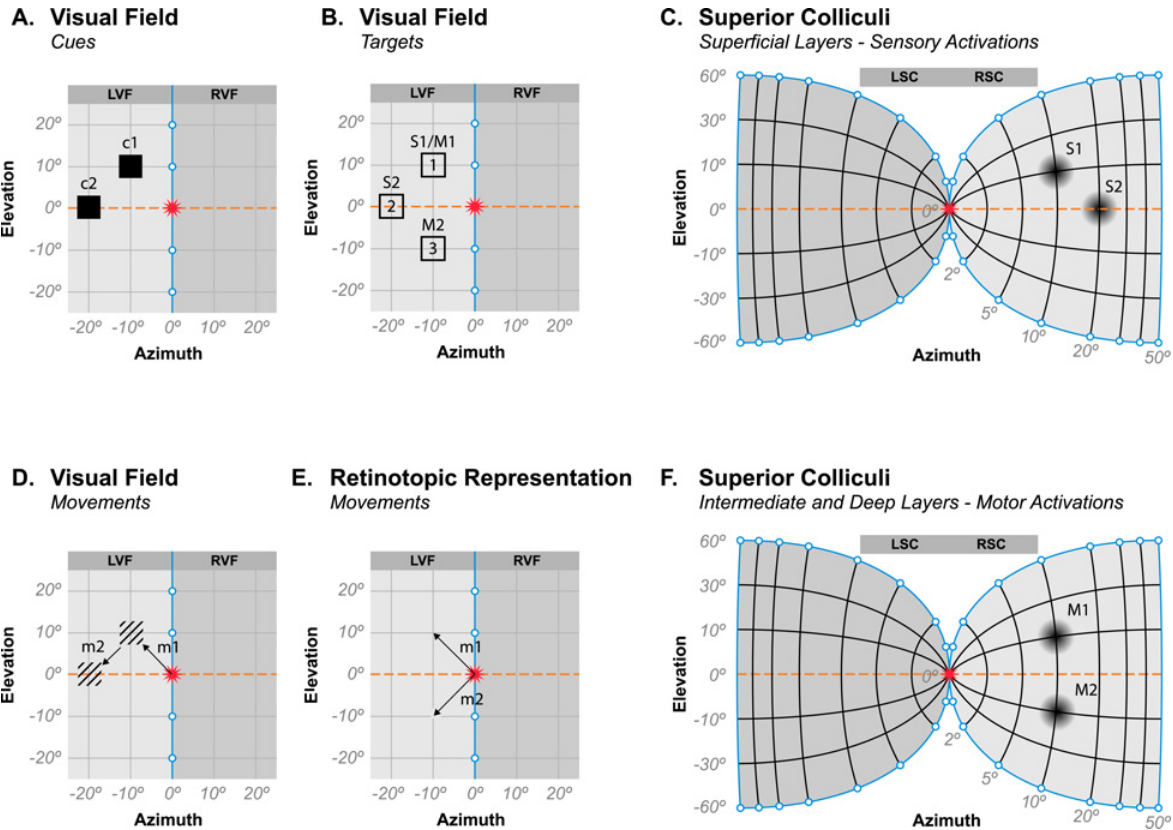
FIGURE 1. Double-saccade paradigm and the SC. (A) Visual field (spatiotopic) representation of cues in the double-step paradigm. Vertical meridian is indicated by the blue line with open circles (—o—o—). Horizontal meridian is indicated by the orange dashed line. The right visual field (RVF) is identified at the top of each panel and distinguished from the left visual field (LVF) by a slightly darker background gray. Two locations in the left visual field are labeled c1 and c2 and indicate the positions of the first and second cue, respectively, when the eyes are fixating the central fixation point (red star at center of display). (B) Visual field representation of possible subsequent target or probe positions. In an IOR paradigm, the initial presentations of cues are followed by a target. This panel indicates 3 possible locations of the target (1, 2, and 3) that are critical to dissociate sensory and motor effects. Notice that 1 and 2 are in the same positions as the cues, c1 and c2, respectively, in panel A. The third possible target location, 3, is located to the left and below fixation (–10° azimuth and –10° elevation). The importance of these positions will be discussed at the end of this caption. (C) Schematic representation of sensory activations, S1 and S2, in superficial layers of the SC to cues (depicted in panel A) presented in locations c1 and c2, respectively. Vertical and horizontal meridians are indicated and depicted as described in panel A. The left SC (LSC) and right SC (RSC) are identified at the top of the figure. Note the expansion of the foveal region representation in the colliculus as well as the reversal of the representation (i.e., the RVF in darker gray is represented in the LSC, also in darker gray). (D) Visual field (spatiotopic) representation of saccades to remembered cues. Because the two cues are no longer present, their locations are indicated by diagonally filled squares. The arrow labeled m1 represents the first saccade from fixation to the remembered location of the first cue, c1. The arrow labeled m2 represents the second saccade from the remembered location of the first cue, c1, to the remembered location of the second cue, c2. (E) Retinotopic representation of saccades to remembered cues. The arrow labeled m1 represents the first saccade from fixation to the location of the first cue, c1. The arrow labeled m2 represents the second saccade from the location of the first cue, c1, to the location of the second cue, c2, remapped in retinotopic coordinates whereby the location of the first cue, c1, is now centered at fixation (red star at center of display). (F) Schematic representation of saccade-related neuron activations, M1 and M2, in the intermediate and deep layers of the SC coupled to the onset of a saccade to the remembered location of the first cue, c1, and to the saccade to the remembered location of the second cue, c2, respectively. Vertical and horizontal meridians are indicated and depicted as described in panel A. Note that the location of saccade-related activations for the eye movement to the second cue, M2 (see panel F) lies in a different part of the SC map than the location of sensory related activations for the second cue, S2 (see panel C). Hence, after the presentation of cues and execution of the double saccade, if a subsequent target is presented at target location 1 in panel B (i.e., same visual field location as c1 in panel A and same motor field location as m1 in panel E) and behavioral inhibition is found, this inhibition can be the result of either sensory (S1, see panel C) or motor (M1, see panel F) activations. However, if a subsequent target is presented at target location 2 in panel B (i.e., same visual field location as c2 in panel A) and behavioral inhibition is found, this inhibition can only be the result of sensory (S2, see panel C) activations. Note that no cue-related activation for the second cue, c2, appears for saccade-related neurons in the intermediate and deep layers (see panel F). Most saccade-related neurons in the intermediate and deep-layers as defined by Mays and Sparks[29] have no, or very weak, visual responses. However, most saccade-related neurons do discharge for a saccade in the absence of a visual target (or visual stimulation of overlying visual cells). Hence, there is activation, M2 (panel F), for the second saccade, m2 (panel E), made to the location of the remembered second cue (note that this activation is in remapped retinotopic coordinates). Thus, after the presentation of cues and execution of the double saccade, if a subsequent target is presented at target location 3 in panel B and behavioral inhibition is found, this inhibition can only be the result of motor (M2, see panel F) activations.